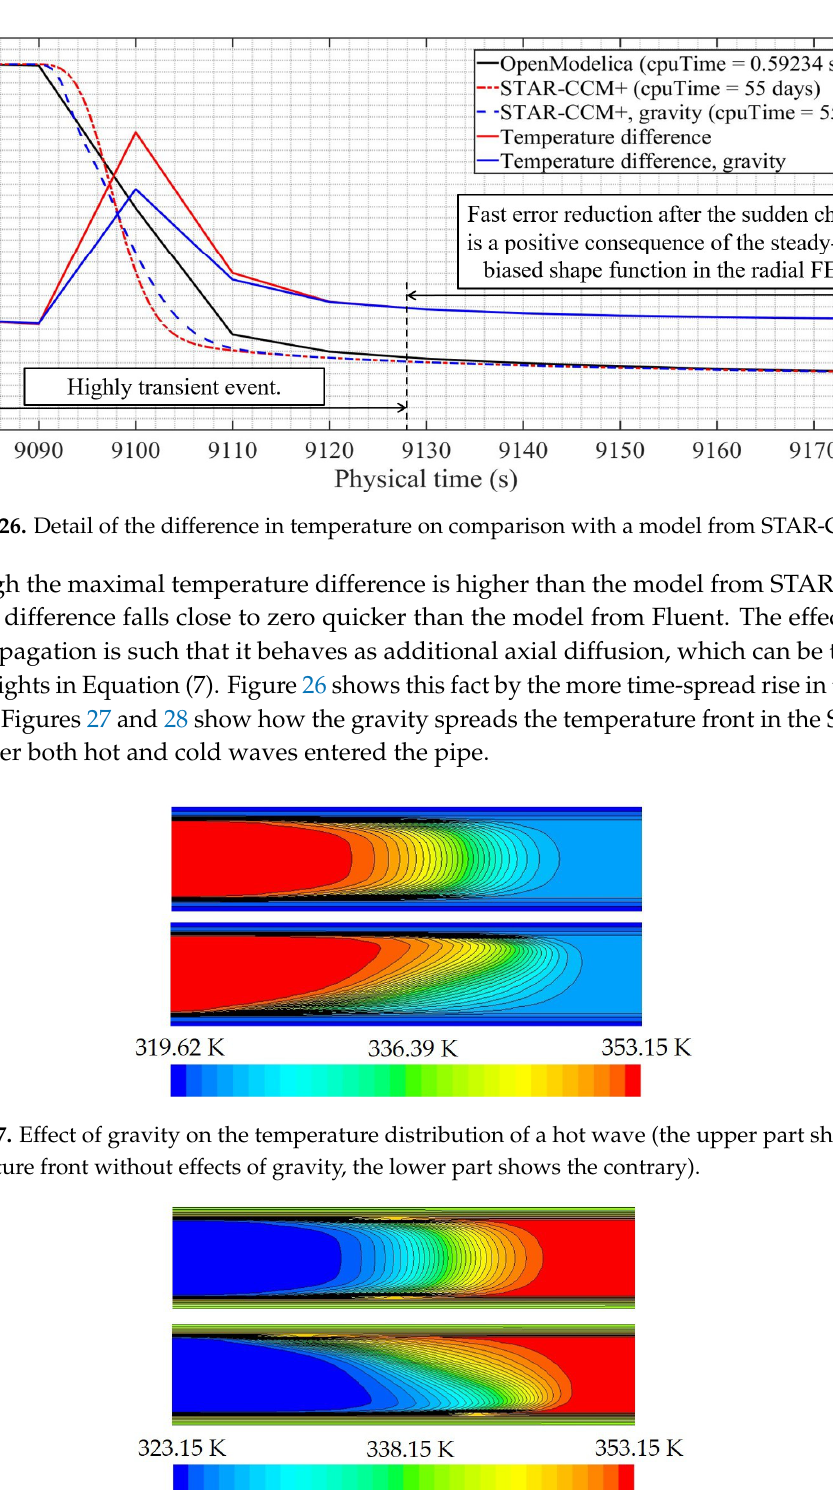
Figure 25. Comparison with a model from STAR-CCM+.